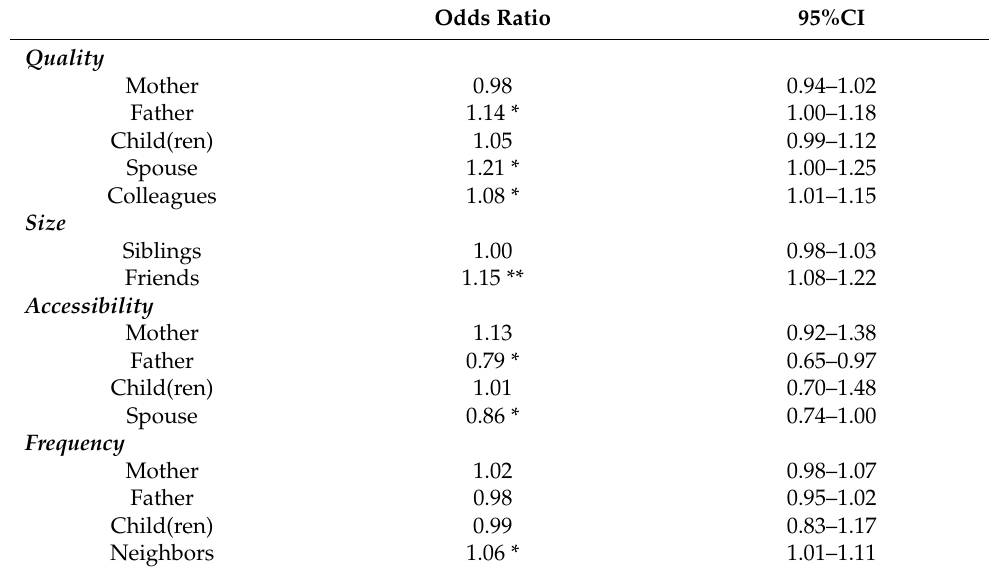
Table 5. The logistic regression for the PA and SN factors in terms of the sociodemographic factors ( N =